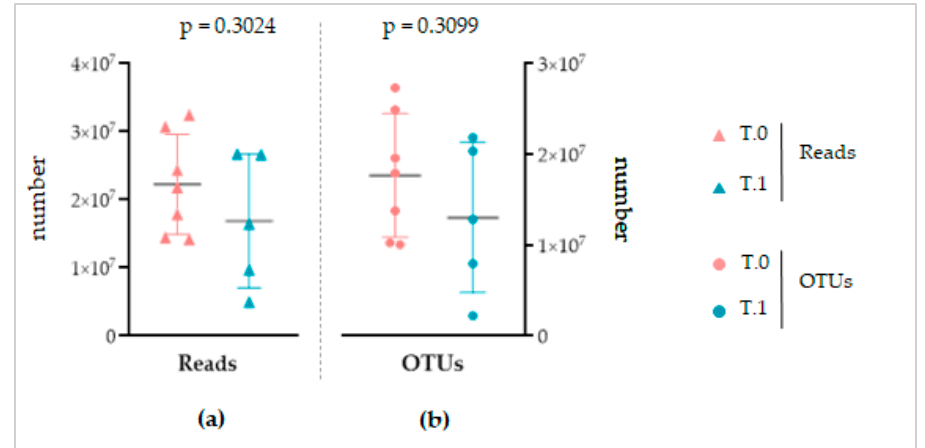
Figure 8. The sequencing output from the Shotgun sequencing. ( a ) The number of reads obtained. ( b ) The number of matched OTUs. The grey horizontal line highlights the average value.